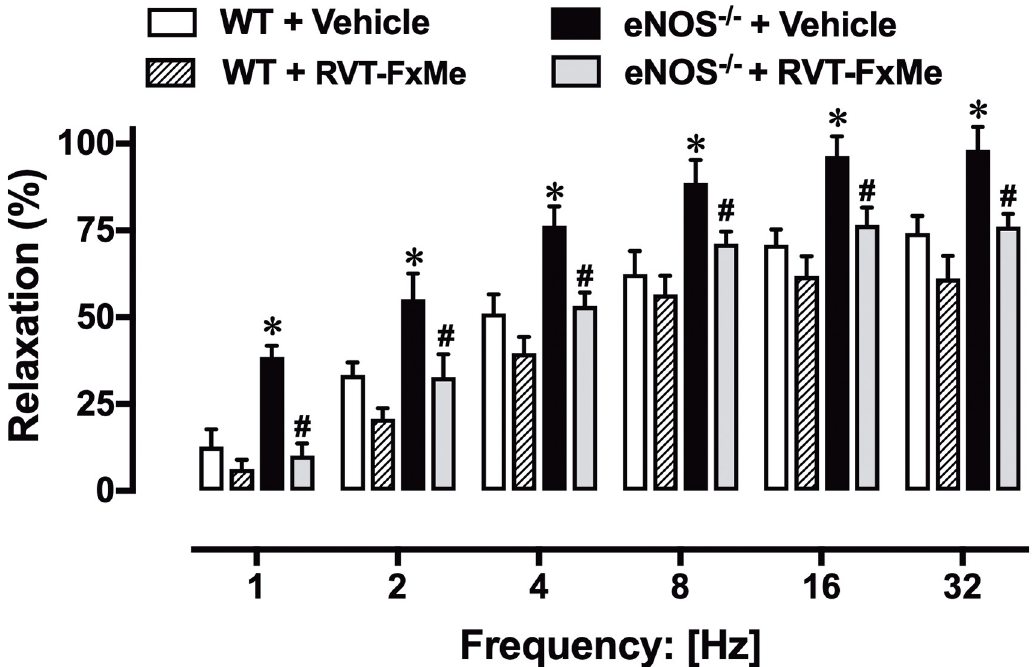
Fig 3. Relaxation responses to electrical-field stimulation (EFS) in corpus cavernosum strips from WT and eNOS -/- mice treated with RVT-FxMe (25 mg/kg/day, 2 weeks) or vehicle. Data were calculated relative to the maximal changes from the contraction produced by phenylephrine (10 − 5 M) in each tissue, which was taken as 100%. Data represent the mean ± SEM for 6 mice in each group. One-way ANOVA: � P < .05 vs WT + Vehicle, # P < .05 vs respective vehicle group.